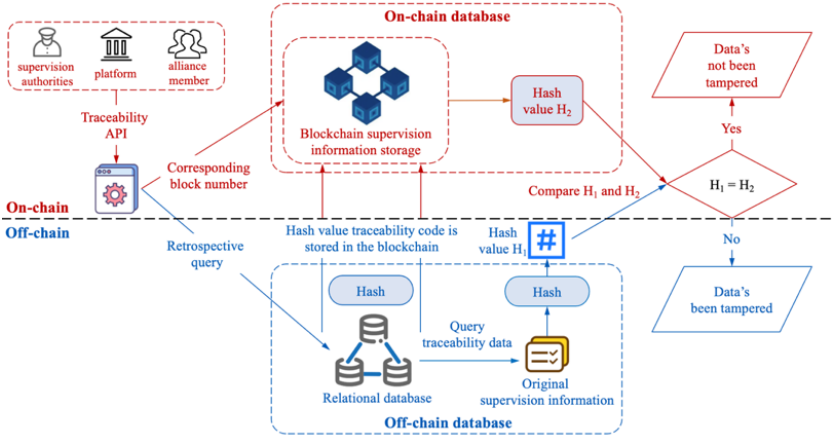
Figure 7. The verification for the traceability process of blockchain data trading supervision infor- mation.